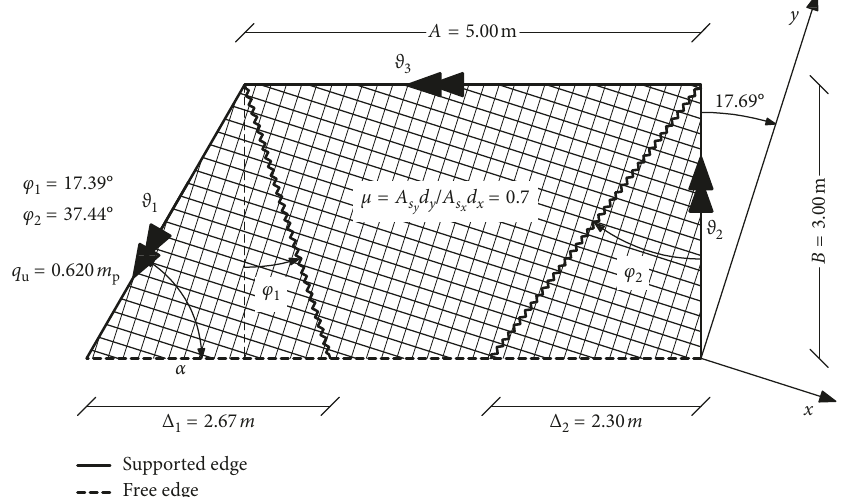
Figure 11: Most favourable reinforcement arrangement.